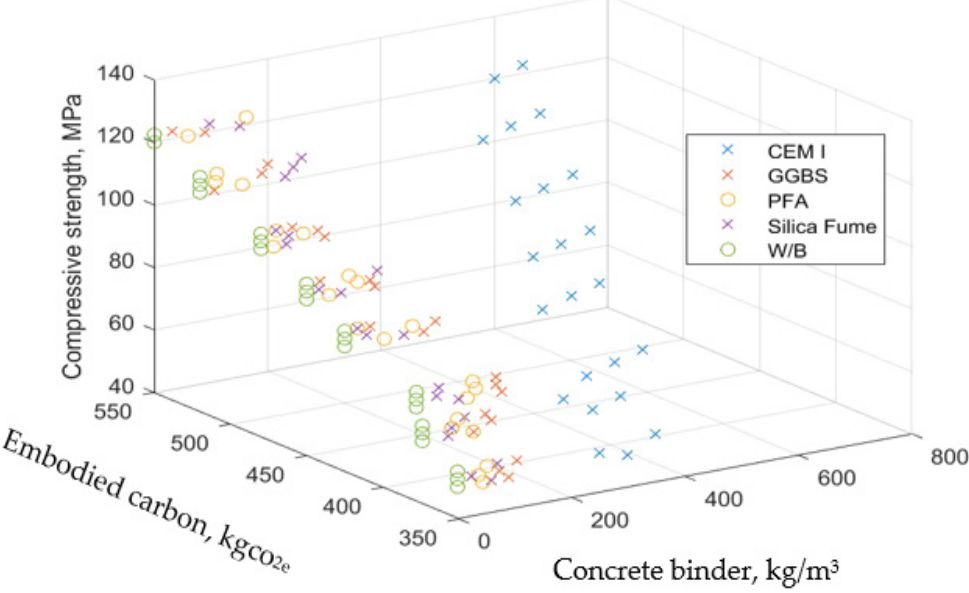
Figure 1. influence of input parameters on compressive strength and embodied carbon.